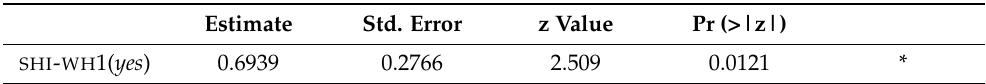
Table 10. Mean acceptability ratings in sub-experiment 3.